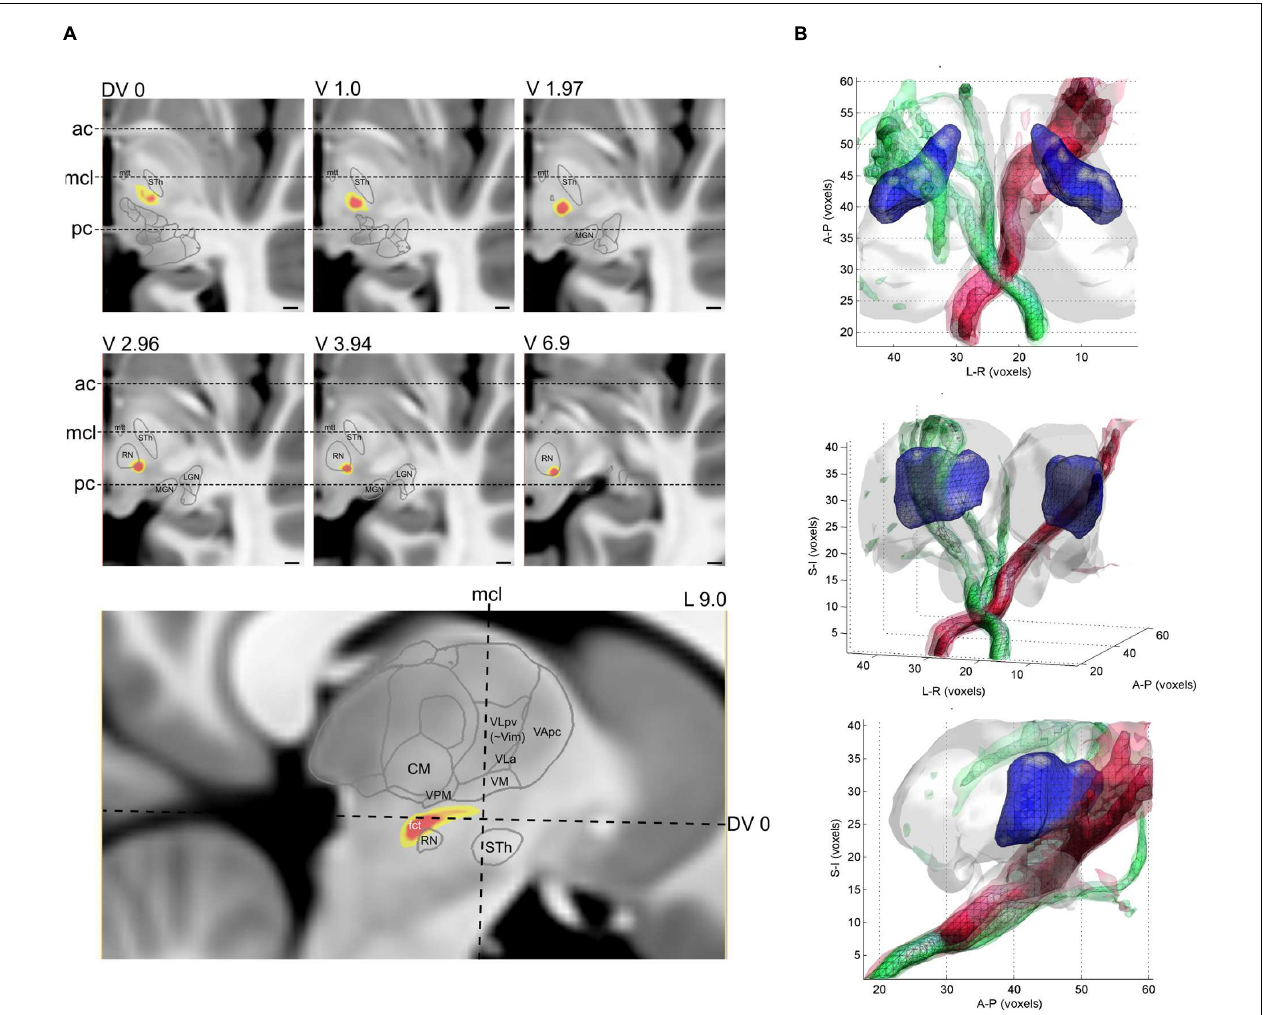
FIGURE 5 | Reconstruction of the CTT with diffusion tractography. (A) population-averaged connectivity map (yellow-red color) overlaid onto a cross-sectional image (T1-weighted MRI). Slice levels are relative to the AC-PC plane, and three major anatomical landmarks have been annotated, ac, anterior commissure, mcl, mid-commissural line, pc, posterior commissure. (B) 3D visualization of the population-averaged CTT. Different opacities correspond to the population probability from 50th percentile to 90th